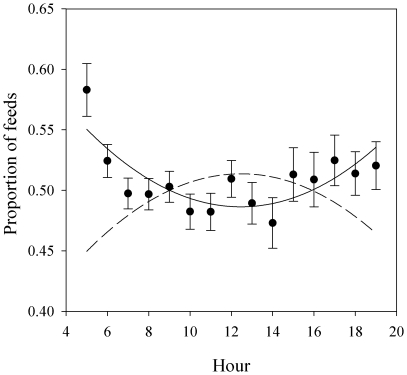
The quadratic relationship between the proportion of visits by a female shown by solid line predicted from the model.Points show the raw mean and standard deviation of all females in the population. The dashed line shows the proportion of feeds by males. The first and last hour are excluded as these are incomplete provisioning hours and feeding behaviour is confounded by roosting behaviour (N = 85 females; 80 males).